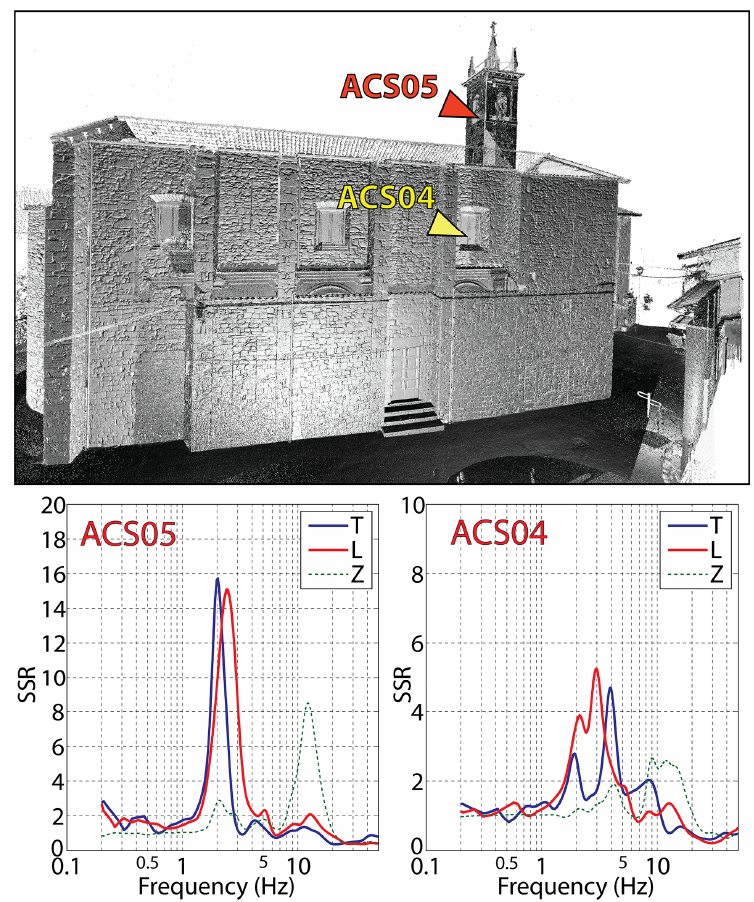
Figure 3. Top panel: geometrical reconstruction of the San Giovanni Battista Church using the terrestrial laser scanner (TLS) data, with locations of the seismic stations. Bottom panel: The standard spectral ratio for each seismic